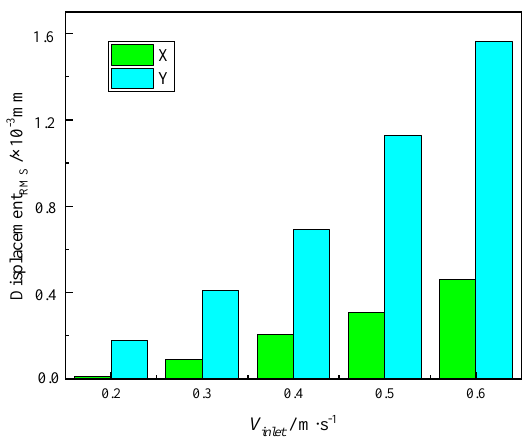
Figure 10. C3 displacement.